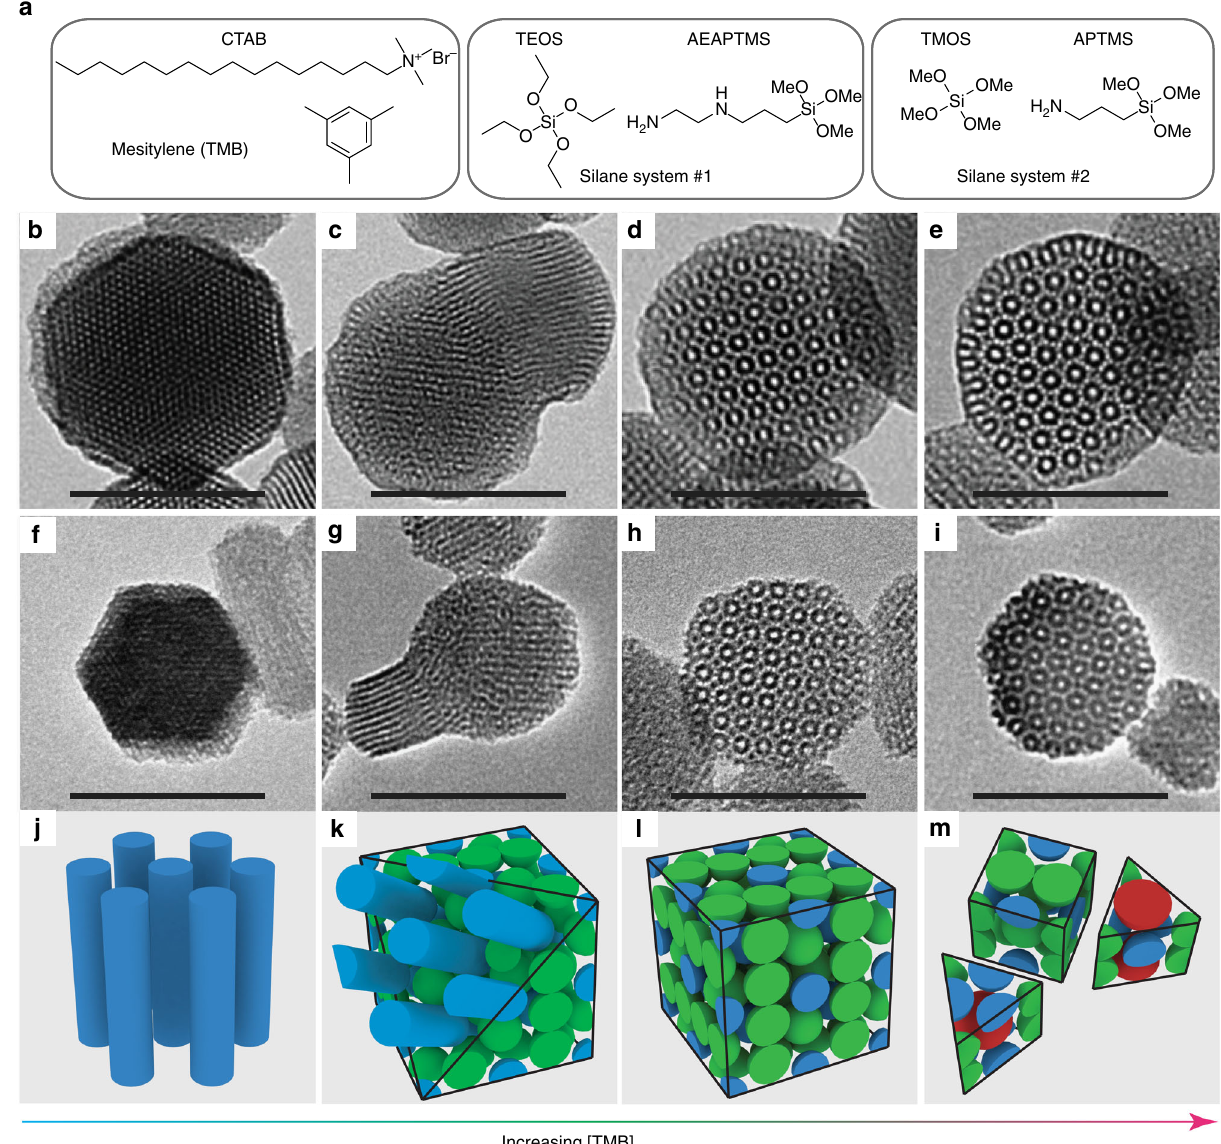
Fig. 1 Four MSN structures observed in two silane systems as a function of mesitylene concentration. a Chemical structures of key reagents used in TEOS/AEAPTMS and TMOS/APTMS synthesis systems. b – e TEM images of MSNs prepared from TEOS/AEAPTMS with 12 mM ( b ), 29 mM ( c ), 47 mM ( d ), and 116 mM ( e ) mesitylene (TMB), using constant ammonium hydroxide concentration (13.8 mM) and stirring rate (650 rpm). f – i TEM images of MSNs prepared from TMOS/APTMS with 4 mM ( f ), 10 mM ( g ), 14 mM ( h ), and 72 mM ( i ) TMB, using constant ammonium hydroxide concentration (150 mM) and stirring rate (600 rpm). j – m Micelle packing models corresponding to MSNs in b – i . All scale bars are 100